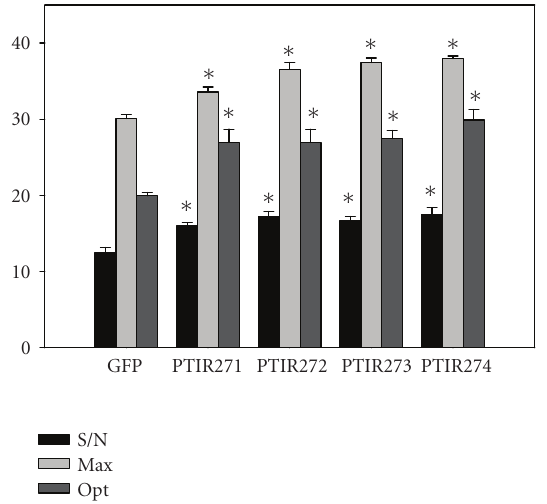
Figure 3: Signal-to-noise ratio (S/N), maximum imaging depth (Max), and optimum imaging depth (Opt) for GFP and long-wavelength PTIR dyes. Maximum imaging depth is the distance between the lung surface and the tumor cell in the lung vessels that still can be imaged using maximum illumination. At optimum imaging depth, high-quality pictures can be obtained with S/N greater than 10. ∗ P < 0 . 05 for all PTIR probes versus corresponding parameters for